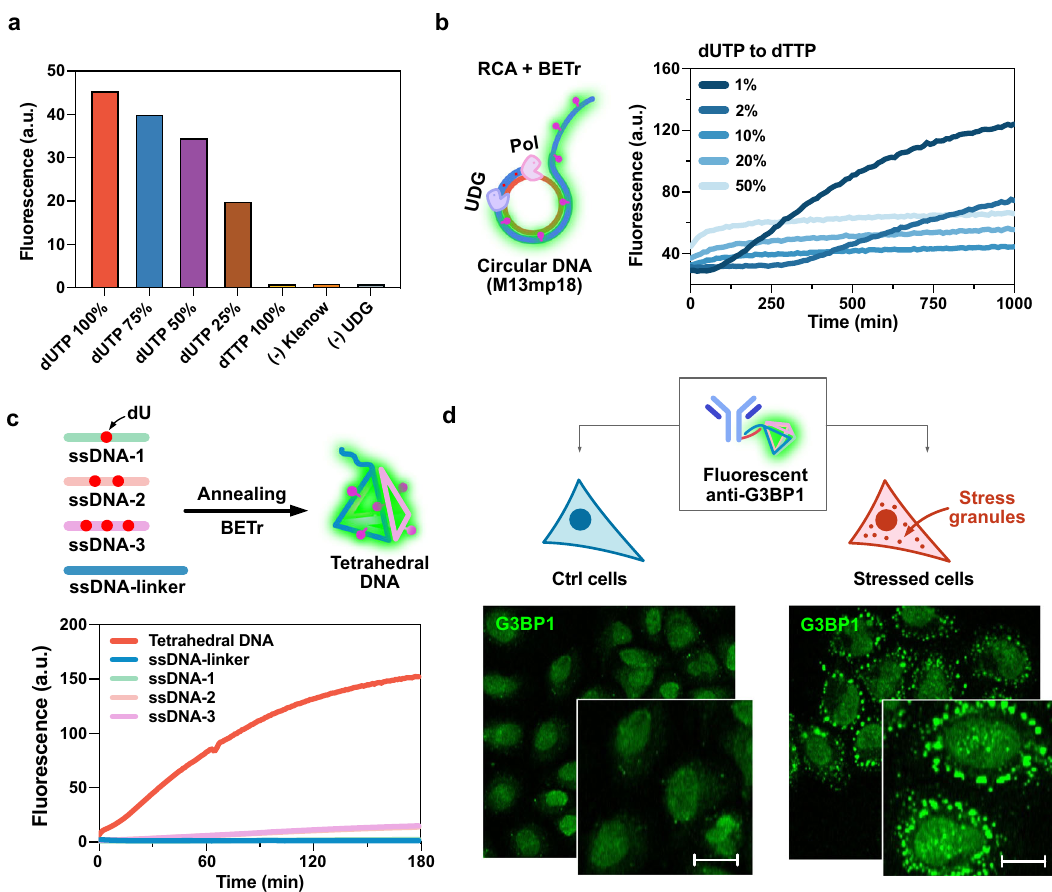
Fig.4|Isothermalsignalampli fi cationandabrightDNAconstructfortagging. Strategies for intense labeling via multiple incorporation of UBER dye into DNAs. a Fluorescence intensity changes of in situ DNA synthesis and BETr labeling with different ratio of dUTP and dTTP. [9dA]=1 µ M, [Primer]=5 µ M, [dUTP]=100 µ M. b Fluorescencechanges in RCA with M13mp18 and insitu BETrlabeling depending ontherelativeratiobetweendTTPanddUTP. c Fluorescenceintensitiesinreal-time BETr labeling of ssDNA components versus the assembled TD. d Direct